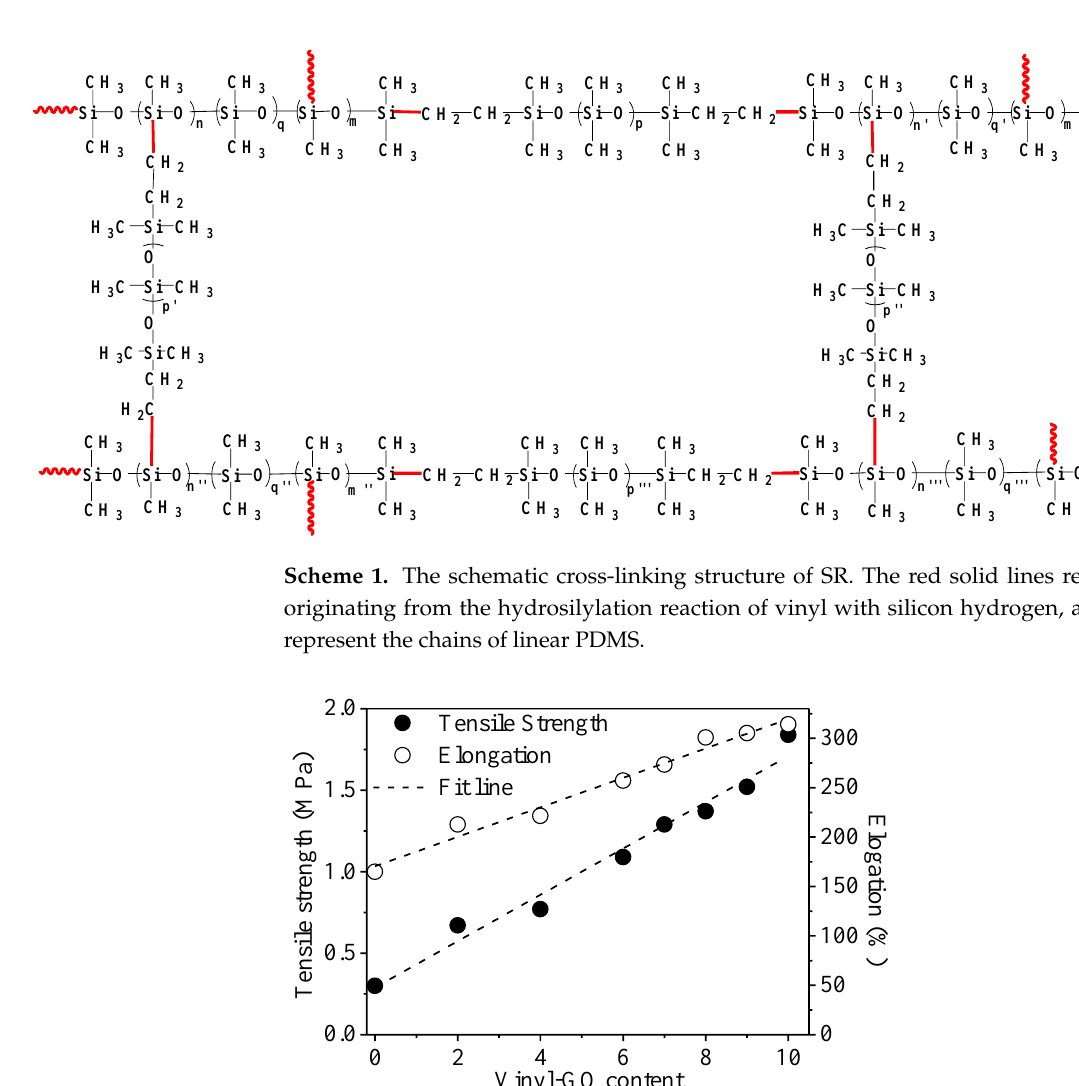
extent. Consequently, SR has a better tensile strength. The schematic cross-linking struc- ture of SR is shown in Scheme 1.